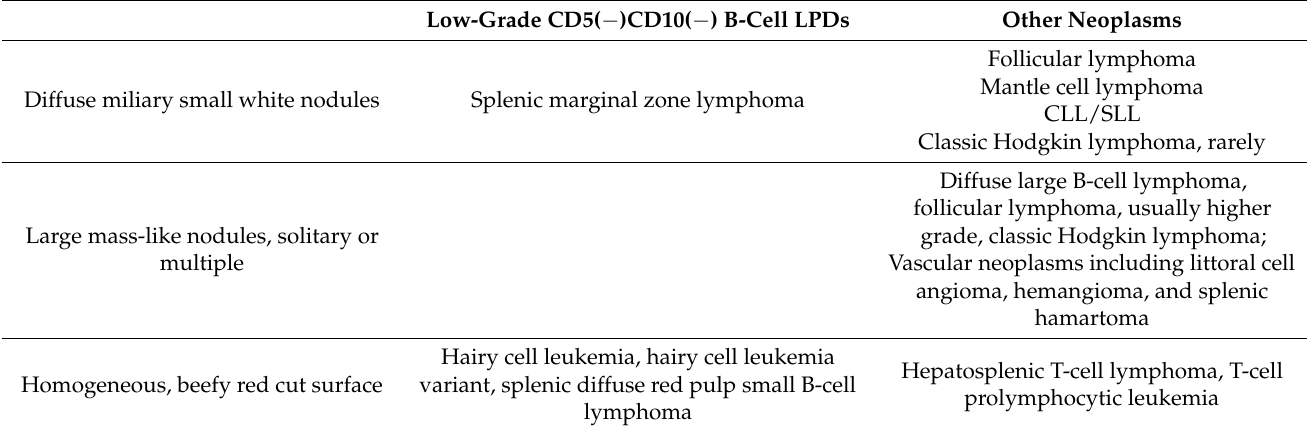
Table 1. Gross manifestations of splenic